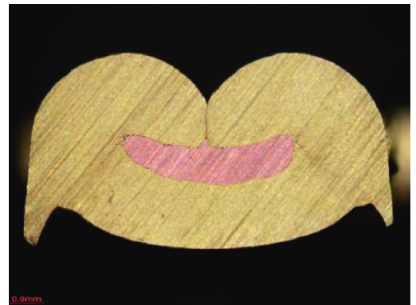
Figure 11: Crimp at a height of 1.25mm.